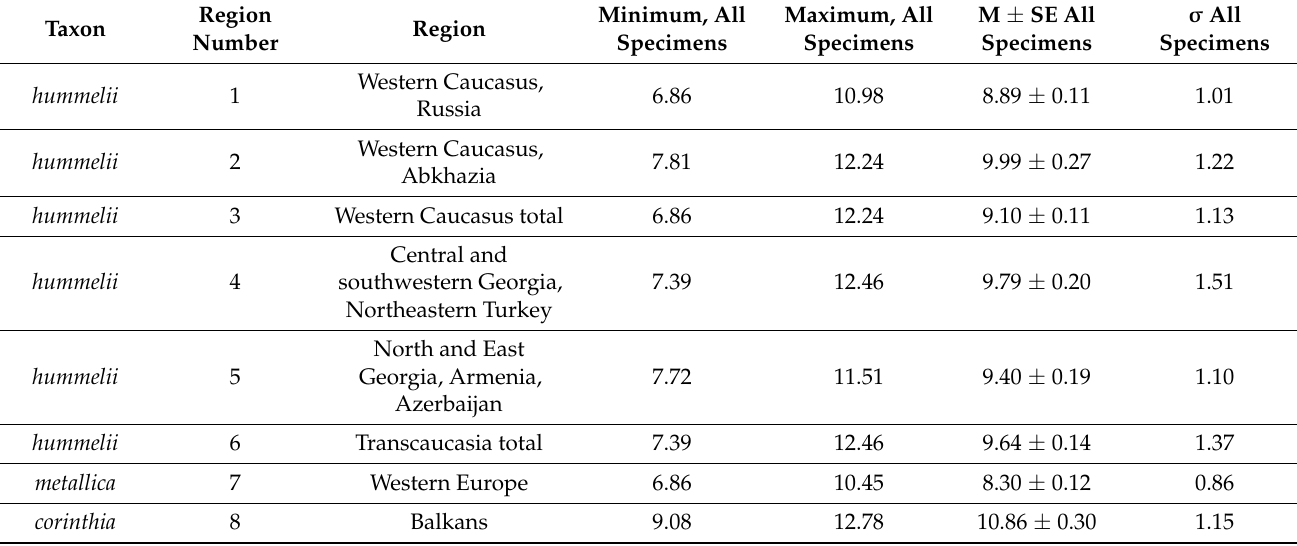
Table 2. Total body length, mm. M—mean value, σ —standard deviations, SE—standard